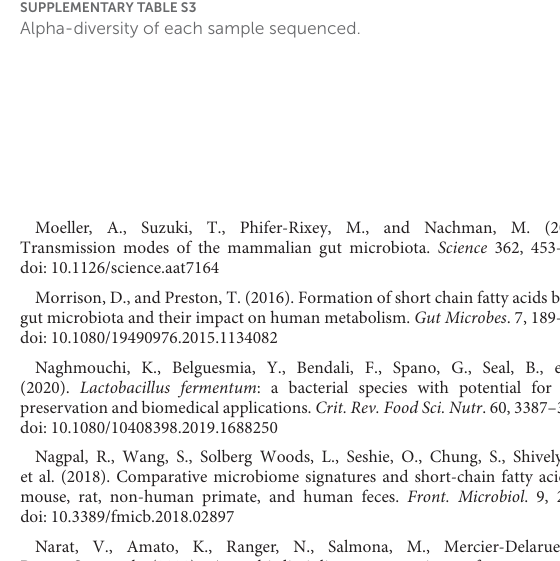
SUPPLEMENTARYTABLES1 General characteristics of sequences of each sample.